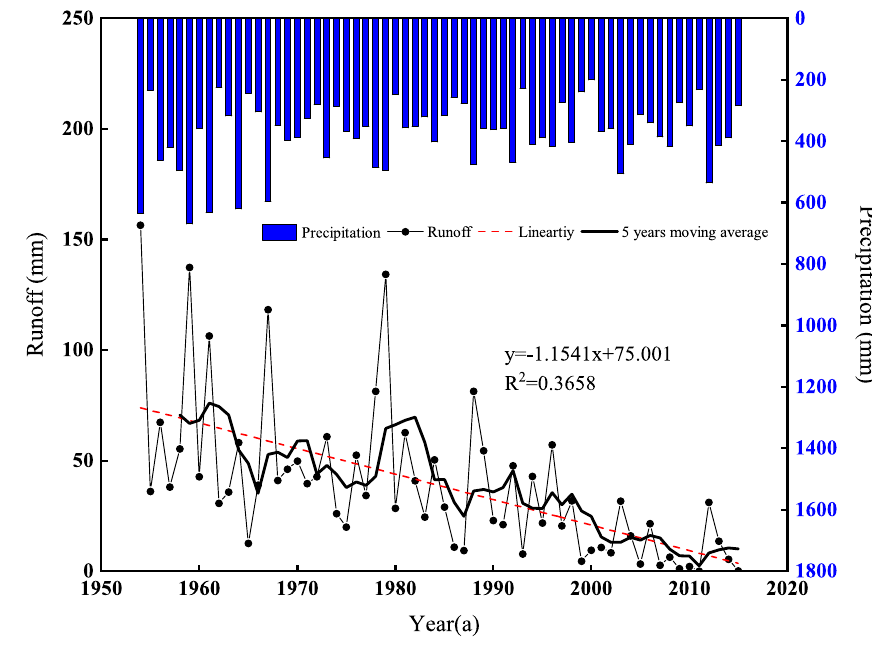
Fig. 2 Annual runoff and